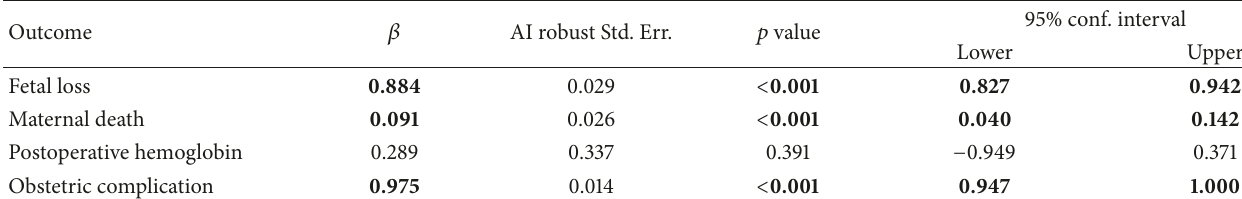
Table 4: Bad outcomes of uterine rupture among study participants in MTUTH, MTU, 2016. Outcome 𝛽 AI robust Std. Err. Fetal loss